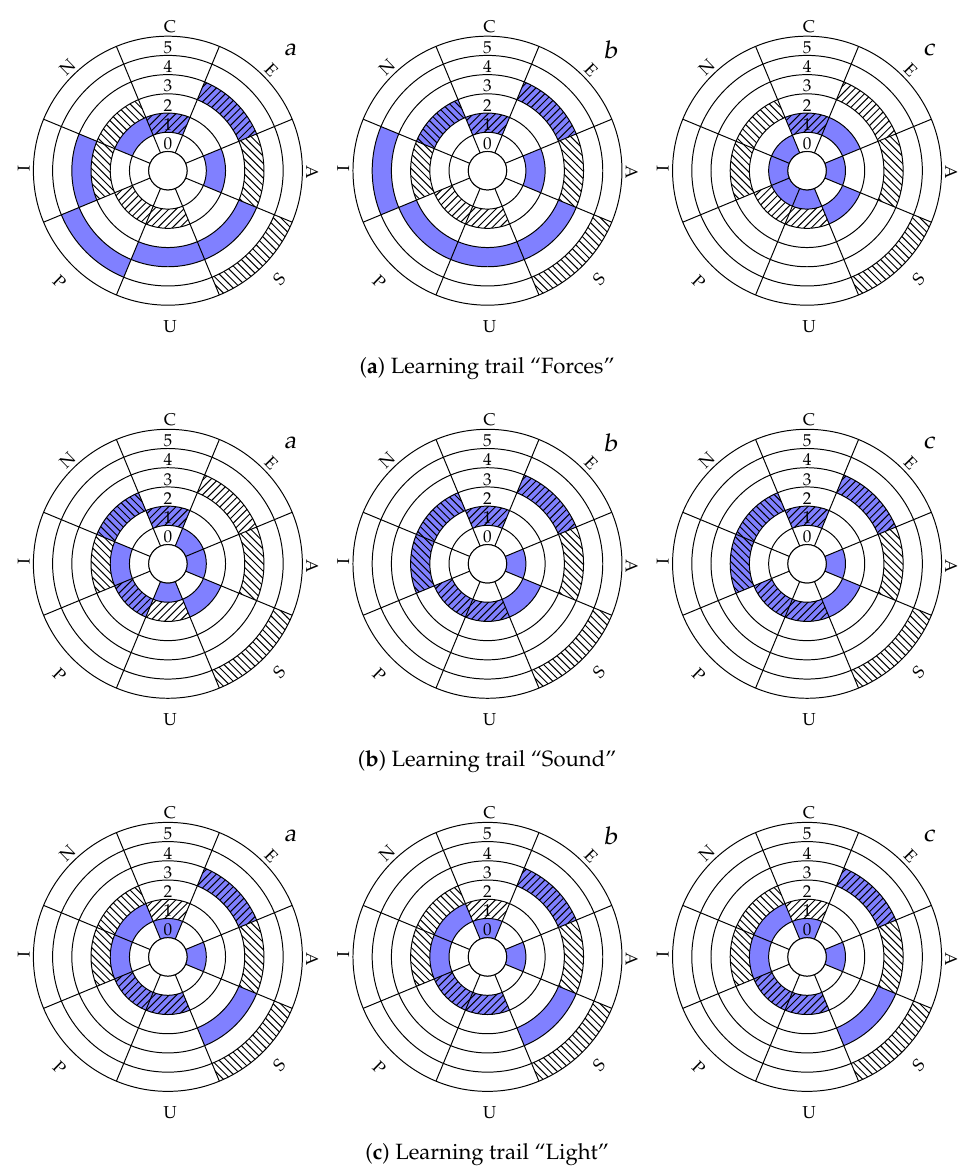
Figure 4. Engagement Profile of the three experiments in the three learning trails (blue markings are for the respective experiment; values for the generic learning trail are hatched).